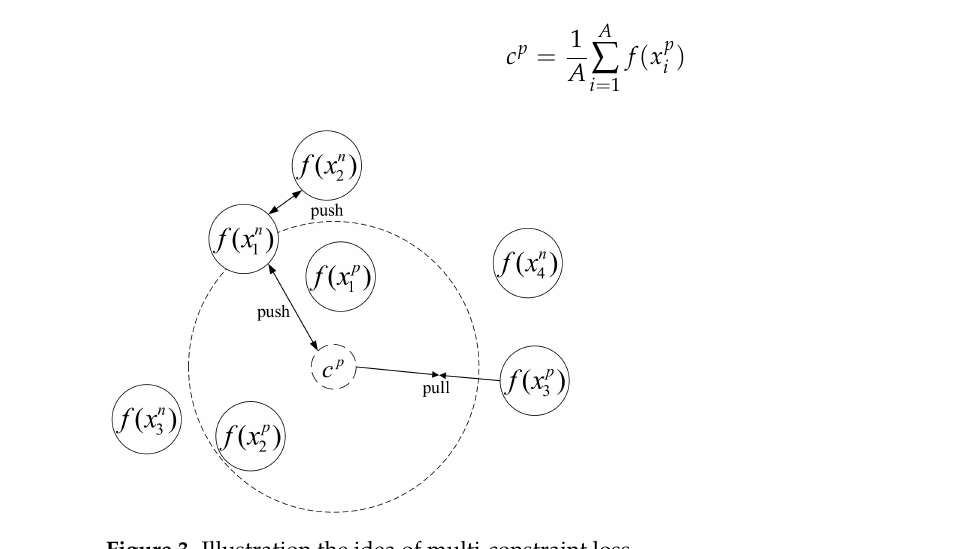
Figure 3. Illustration the idea of multi-constraint